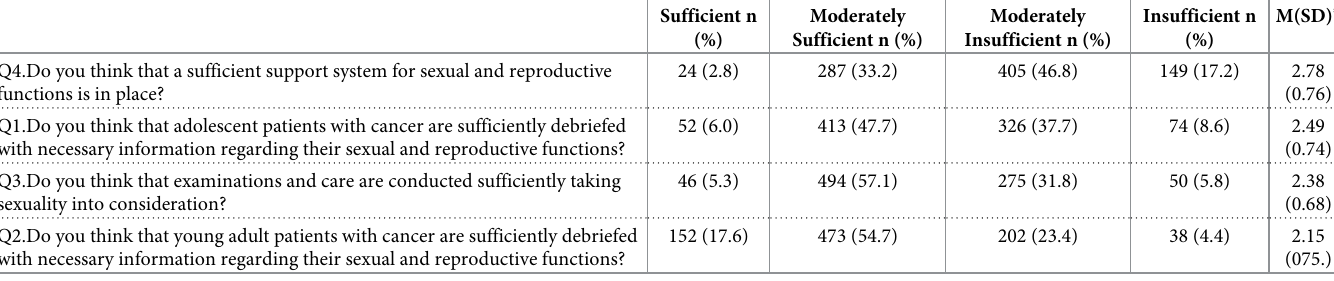
Table 2. Nurse’s perception of support for sexual and reproductive issues among AYA. n = 865.